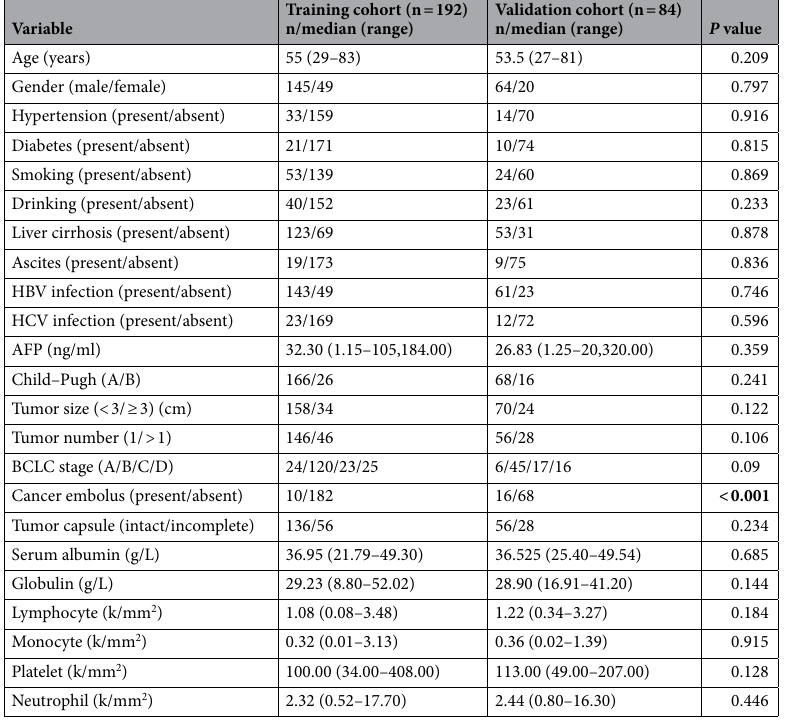
Table 1. Baseline demographics and clinical characteristics of patients in training cohort and validation cohort. P value of less than 0.050 was considered to indicate significant difference. AFP alpha-fetoprotein, HBV hepatitis B virus, HCV hepatitis C virus, BCLC Barcelona clinic liver